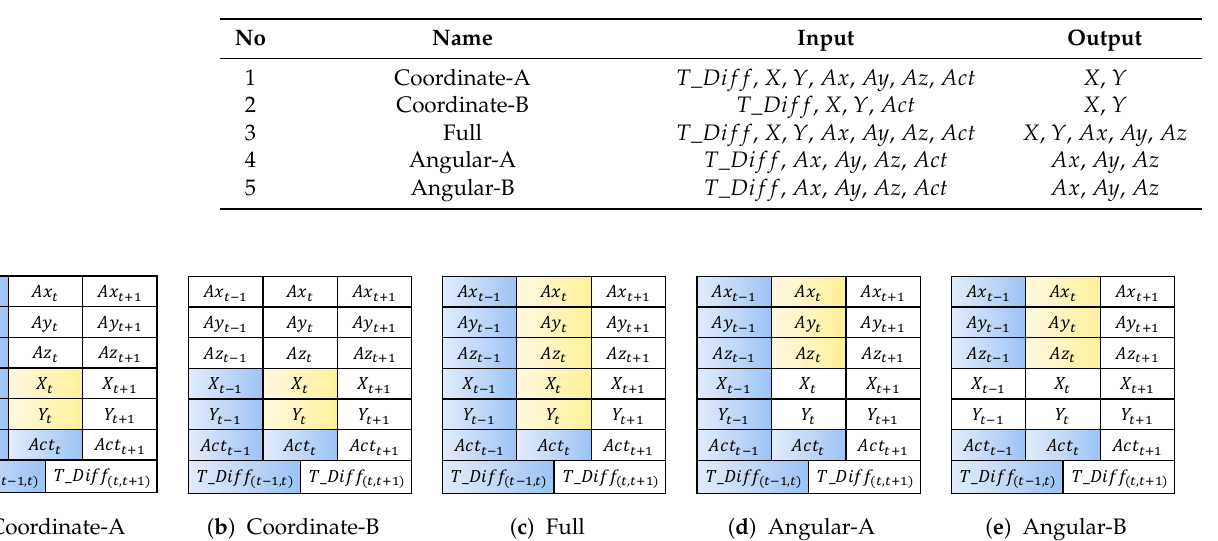
Table 6. Five combinations of variable sets used in the study.